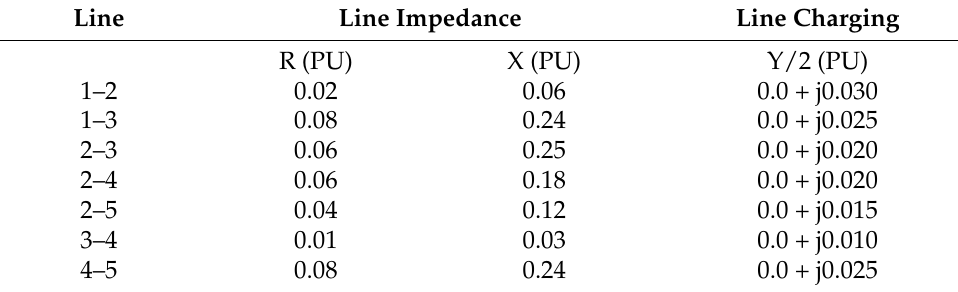
Table 1. Impedance parameters of the 5-Bus